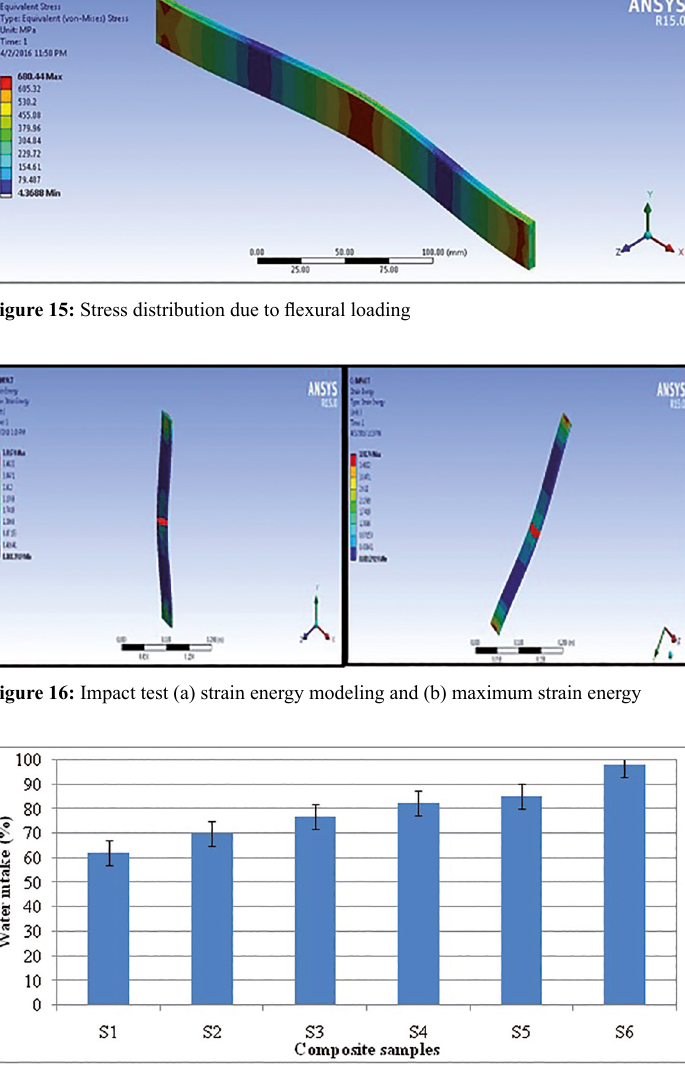
Figure 17: Water intake comparison of carbon/banana fiber reinforced hybrid